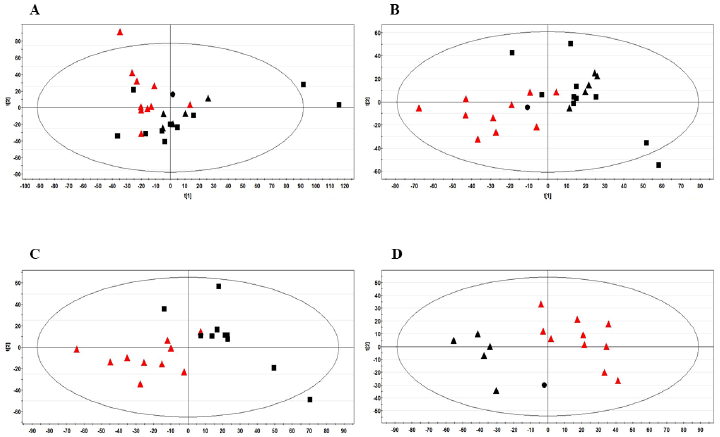
Figure 1. ( A ) PCA and ( B ) PLS-DA score plots obtained by 1 H-NMR analysis on FF samples from all the 26 women examined in the study. The R 2 X and Q 2 values for the two-component PLS-DA model were: 0.35 and 0.34, respectively. PLS-DA score plot between healthy women (n = 10) and: ( C ) BC patients with no lymph node metastasis (n = 10); ( D ) BC patients with lymph node metastasis (n = 6). The R 2 X and Q 2 values for the two-component model reported in ( C ) were: 0.37 and 0.32, respectively; the corresponding values for the two-component model shown in ( D ) were 0.36 and 0.54, respectively. Data were colored by group: healthy controls were represented with red triangles; BC patients are shown in black using di ff erent symbols: patients with no lymph node metastasis (n = 10), boxes; patients with N1 (n = 5) and N2 lymph node metastasis (n = 1), triangles and dot, respectively.